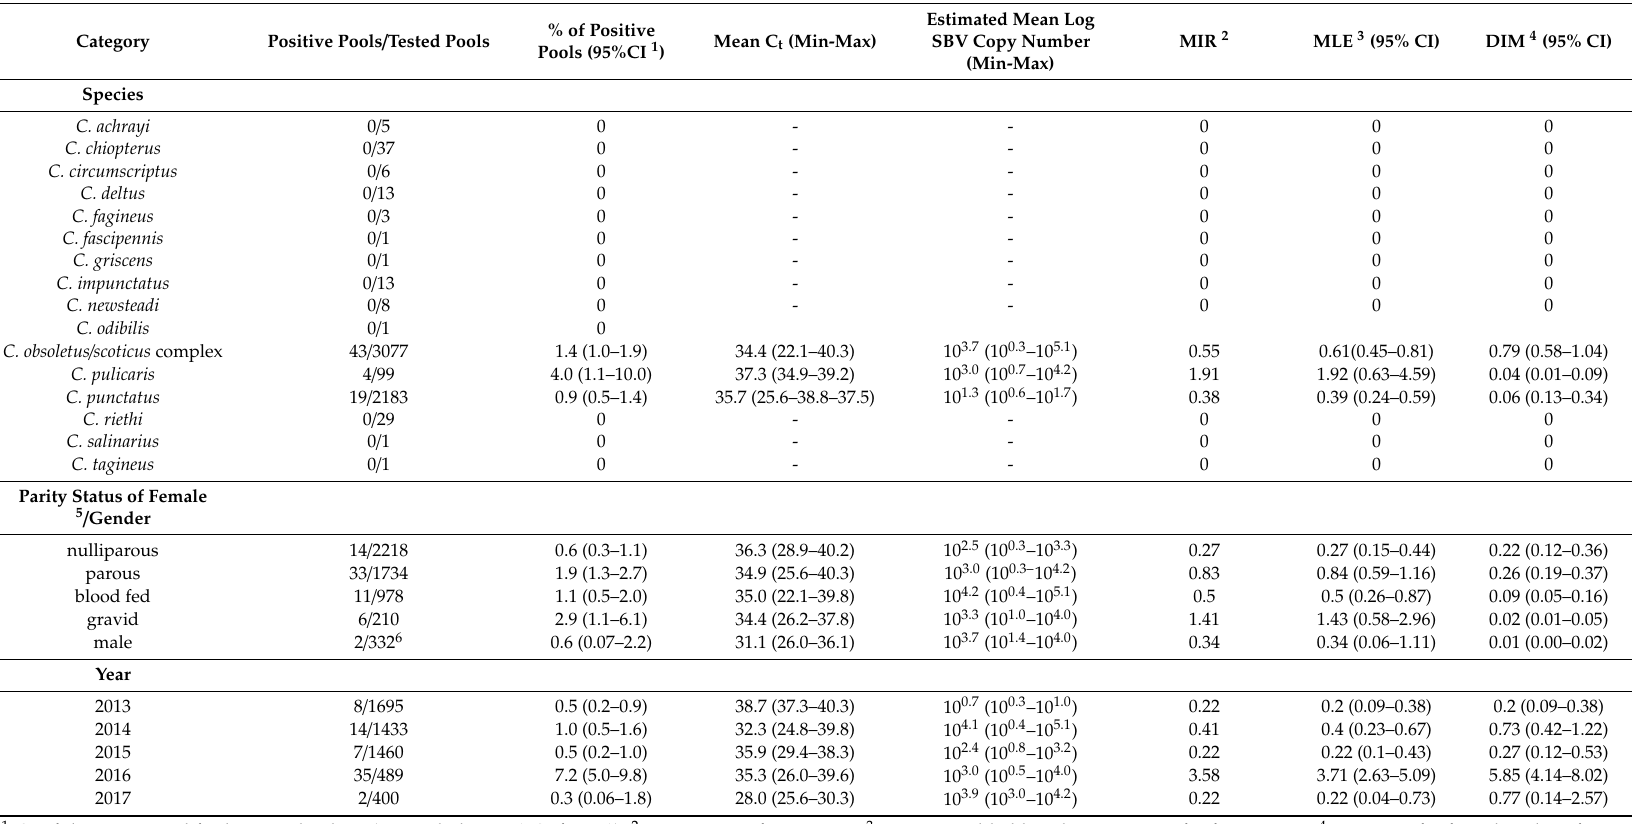
Table 1. Sampling data, results of QRT-PCR for Schmallenberg virus (SBV) detection, and infection rate